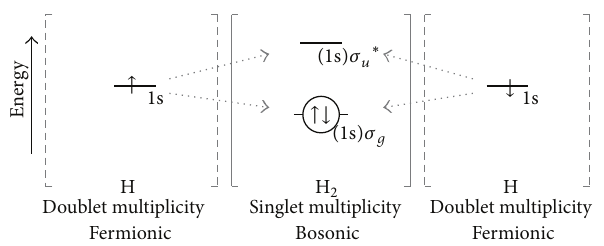
Figure 2: Combination of two doublet multiplicity hydrogen atoms (H, shown on the left and right of the graphic) yields singlet multiplicity molecular hydrogen (H 2 , shown in the center of the graphic). Multiplicity is defined as |2(𝑆)|+1 , where 𝑆 is the total spin number. Constructive overlap of the two antisymmetric 1s SOAOs of the H atoms yields the HOMO 𝜎 of H 2 . The (1s) notation before 𝜎 indicates the atomic source of the molecular orbital. 𝜎 ∗ is the LUMO antibonding orbital ( ∗ indicates antibonding) of H 2 . The energy differences in the figures are for illustration and not drawn to scale.